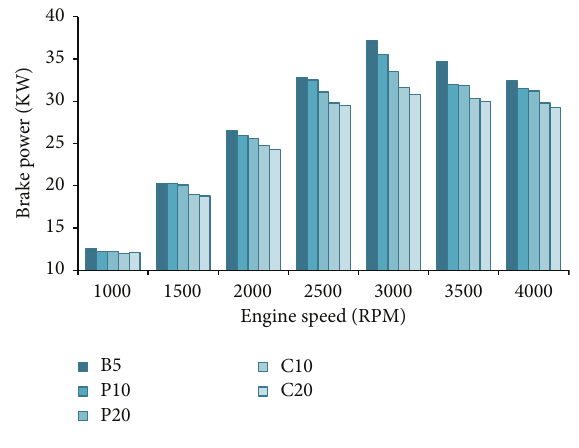
Figure 3: Brake power ( 𝑃 𝑏 ) at full load.